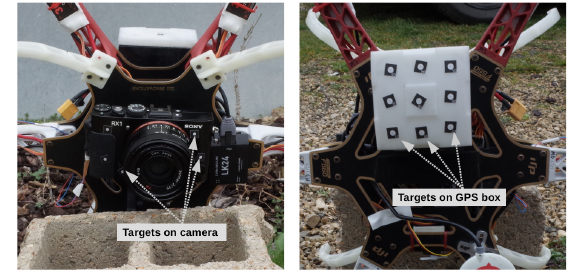
Figure 3: Targets on camera and GPS receiver box The method consists on determining the position of the optical center of the camera and the position of the GPS antenna phase center in the local frame of each sensor (the local frame is mate- rialized by target network).